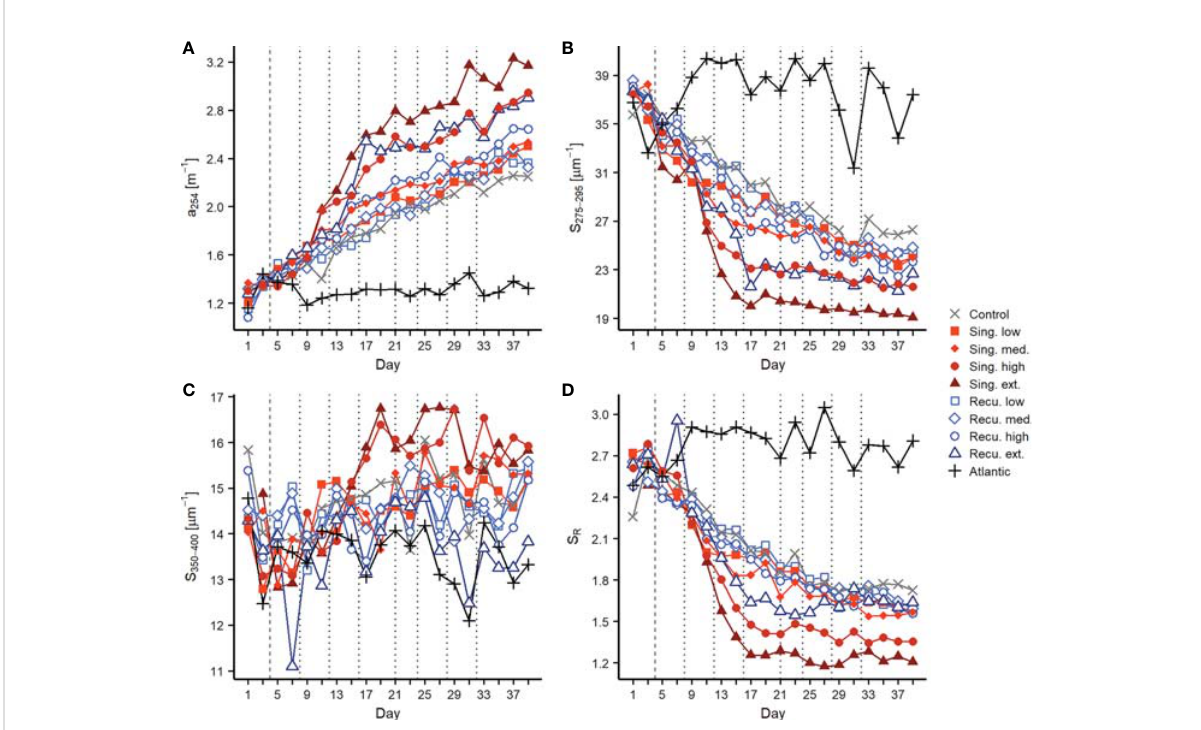
FIGURE 4 Changes in chromophoric dissolved organic matter during the experiment. Temporal development of (A) CDOM quantity as a 254 , (B) S 275-295 , (C) S 350-400 , and (D) S R . Vertical lines indicate deep water additions of singular (dashed) and recurring (dashed and dotted) treatments. See explanation of parameters in the Methods